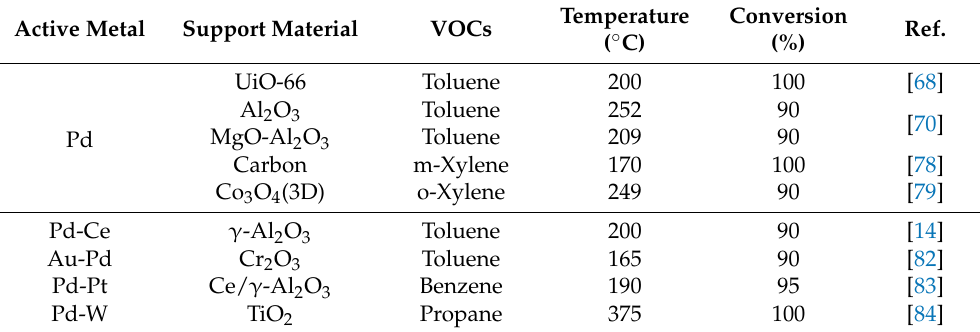
Table 4. Comparison of Pd-based catalysts on various supports for VOC